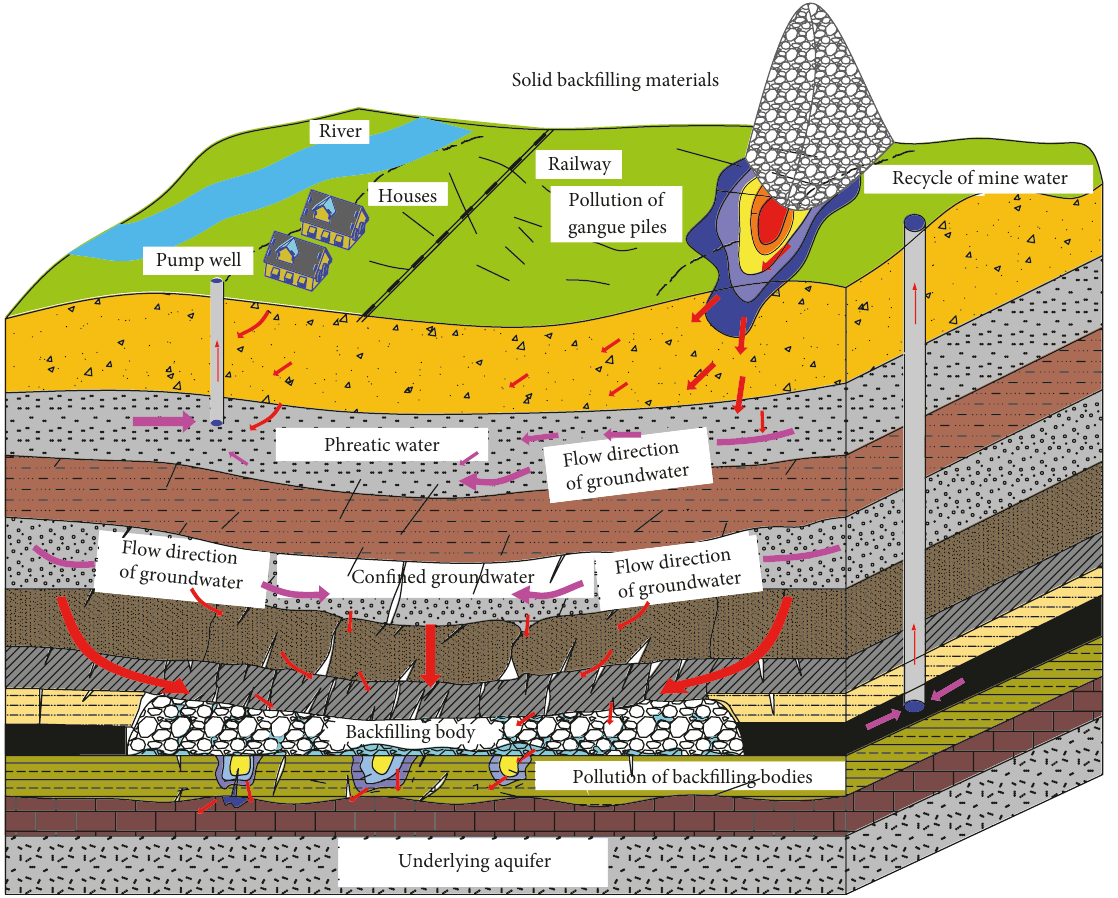
Figure 1: Schematic of groundwater pollution from coal gangue back fi lling in